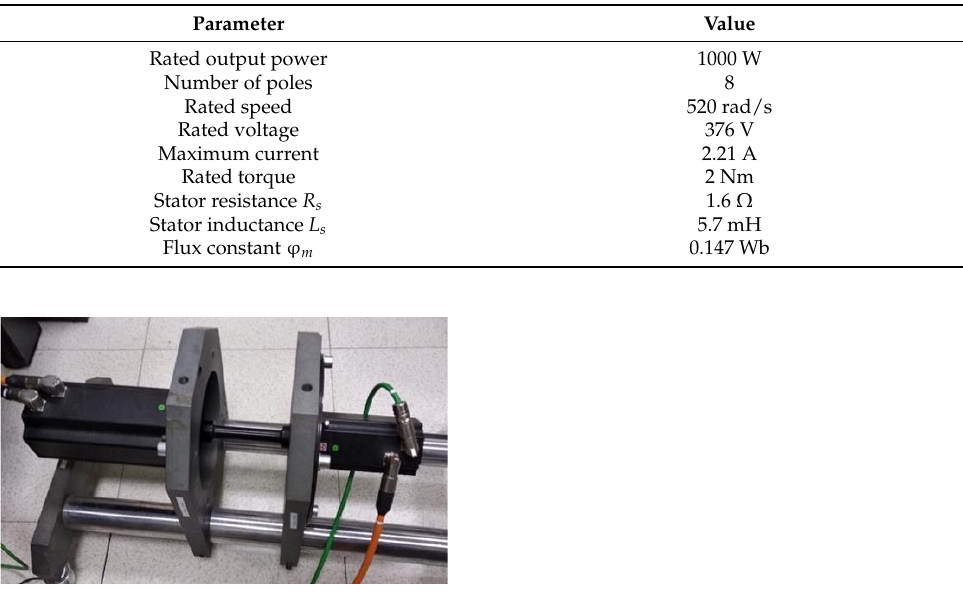
Figure 12. SPMSM under test (motor on the right) and SPMSM used to generate the load torque (motor on the left).